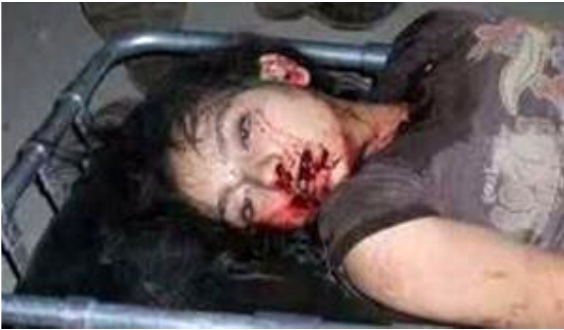
Figure 5. A falsely attributed image that appears to